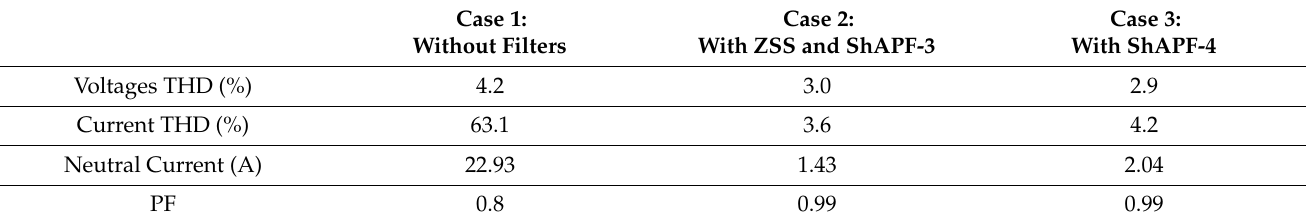
Table 6. Comparison of results for cases 1, 2, and 3.